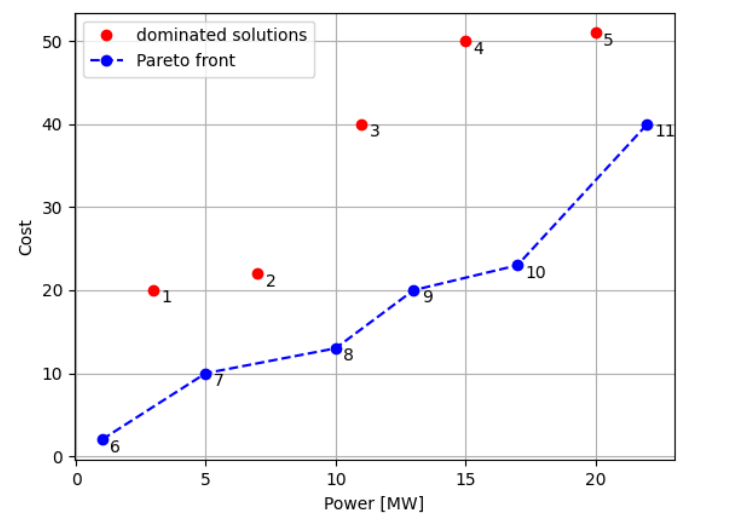
Figure 5. Theoretical set of